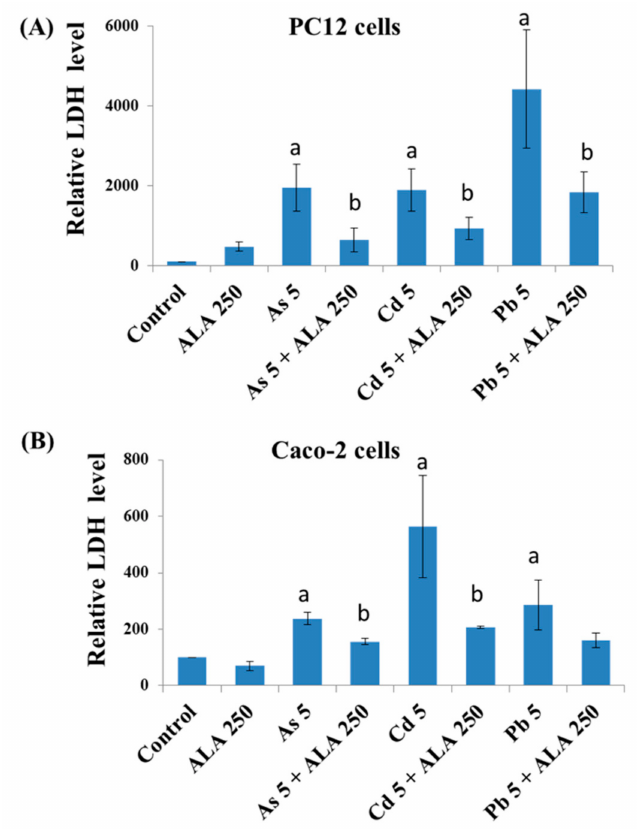
Figure 5. Lactate dehydrogenase (LDH) activity of ( A ) PC12 cells and ( B ) Caco-2 cells in cell culture medium after exposure to toxic metals and/or ALA for 48 h of exposure. The values of the bars indicate the mean ± SEM ( n = 3). Here, “a” denotes a significant difference compared to the control group ( p < 0.05), and “b” denotes a significant difference compared to the associated metal group ( p <